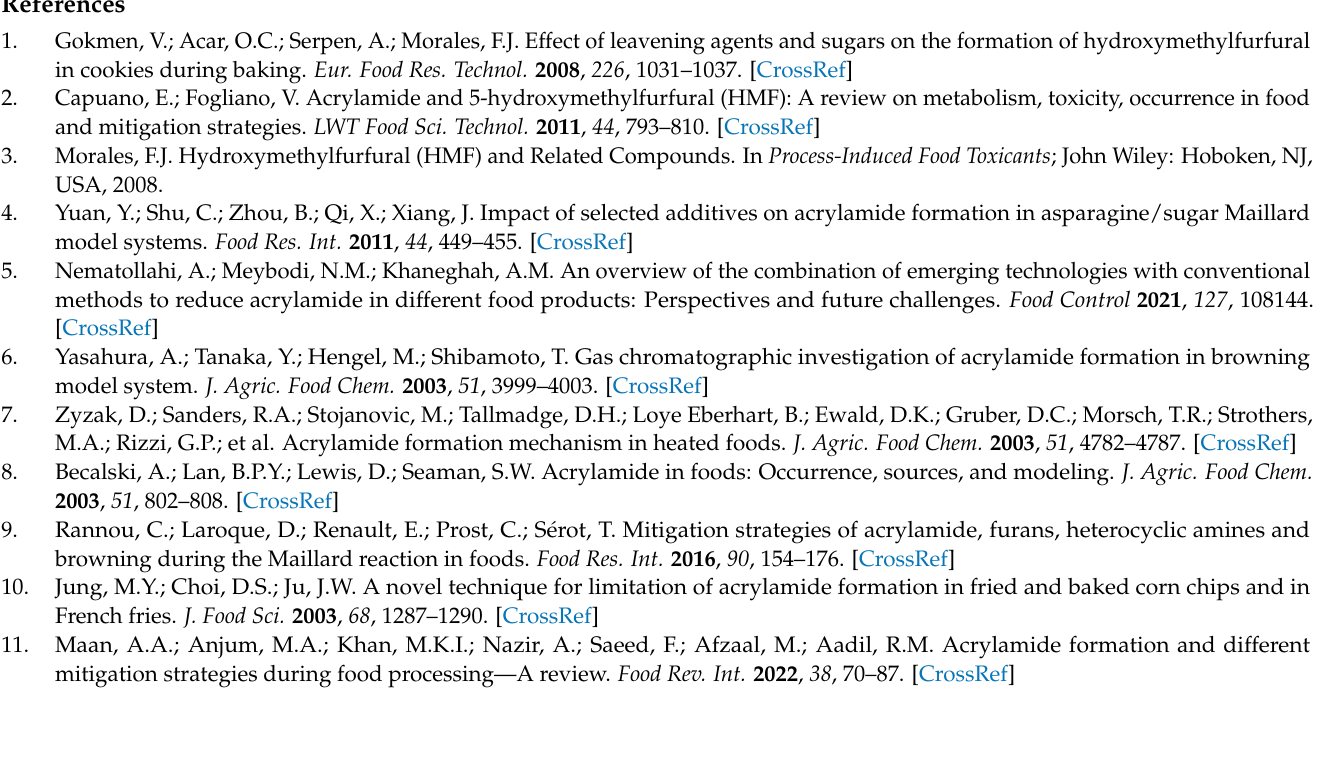
the manuscript. Table S1 Correlation analysis of sodium alginate concentration, acrylamide content, pH value, DPPH radical scavenging activity, reducing power and CIE color value of biscuits. Table S2 Correlation analysis of pectin concentration, acrylamide content, pH value, DPPH radical scavenging activity, reducing power and CIE color value of biscuits. Table S3 Correlation analysis of chitosan concentration, acrylamide content, pH value, DPPH radical scavenging activity, reducing power and CIE color value of